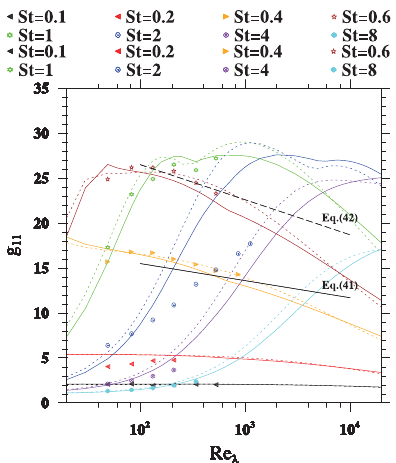
Figure 3. Radial distribution function at the contact of monodis- perse particles, g 11 , against Re λ . The plotted points are the refer- ence DNS results, the dotted lines are the prediction with the coef- ficients of Onishi et al. (2015), and the solid lines are the present prediction.